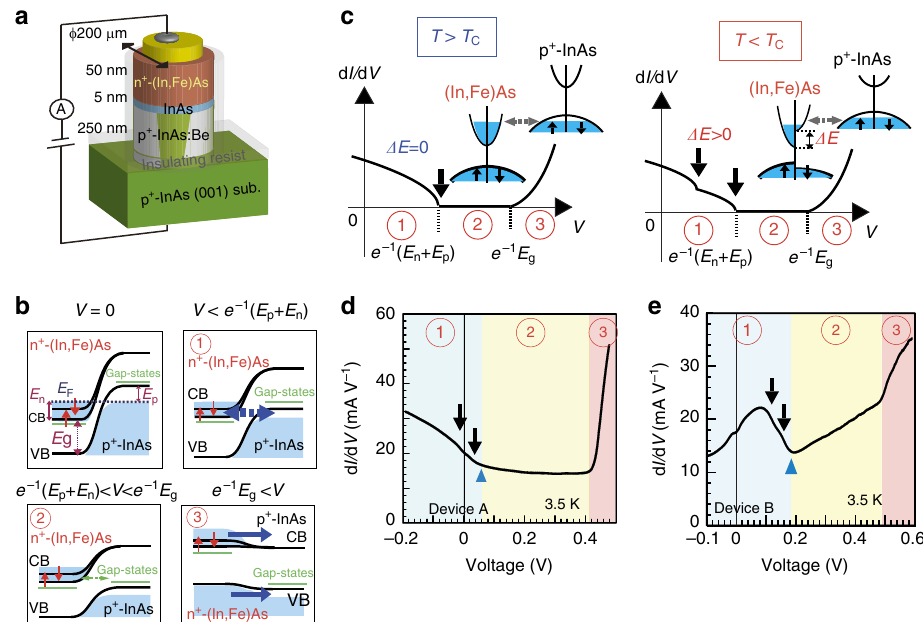
Figure 1 | Device structure, transport mechanism and d I /d V – V curves of (In,Fe)As-based Esaki diodes. ( a ) Device structure and transport measurement configuration of the spin-Esaki diodes used in this study. ( b ) Band profiles corresponding to the case of zero bias and three regions ( (cid:2) : Tunnelling region, ` : Band-gap region, ´ : Diffusion region) of the spin-Esaki diodes. The (In,Fe)As conduction band (CB) is spin-split, and two red arrows represent the up and down spin bands. E g is the band-gap energy of (In,Fe)As, E F is the Fermi level, E n , E p are the quasi-Fermi levels in the n þ -(In,Fe)As and p þ -InAs electrodes, respectively. Green lines in the band-gap represent gap states coming from heavily-doped impurities. ( c ) Illustration of the change in the band structure of (In,Fe)As and the d I /d V – V curve of the Esaki diodes at temperature above (left panel) and below (right panel) T C . The spin-splitting in density of states (DOS) of the (In,Fe)As CB leads to the ‘kink’ structure (pointed by two black arrows) in the d I /d V – V curve at low temperature ( T o T C ). ( d , e ) d I /d V – V characteristics of devices A and B measured at 3.5K, respectively. Blue, yellow and pink areas correspond to the tunnelling region, band-gap region and diffusion region in each device. Blue triangles indicate the bending positions. Two black arrows point to the kink structures in each d I /d V – V